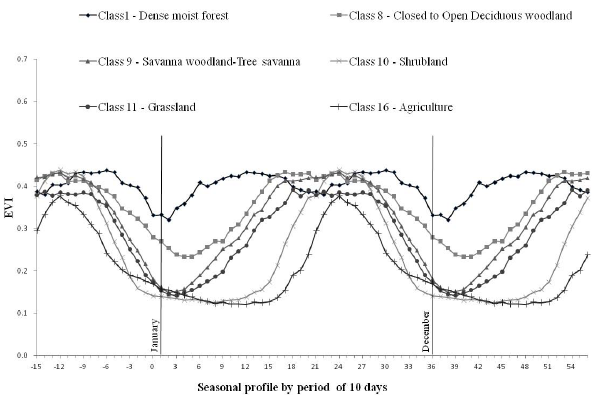
Fig. 6. EVI Seasonal profile by period of 10 days (January to De- cember between the vertical lines) for classes (1, 8, 9, 10 11 and 16) situated in the northern zone.